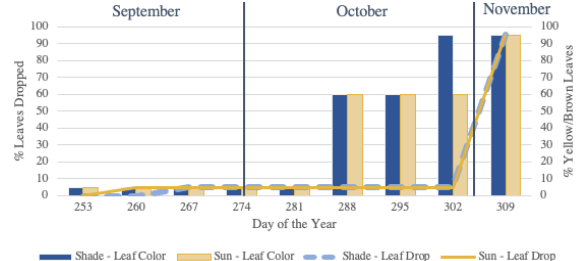
Figure 8. Temporal changes in leaf color change (bars) and leaf drop (lines) recorded in fall 2015 in the aspen trees growing in shaded (blue) and sunny (yellow) areas. October 2015 had fewer days with the minimum temperature dropping below the freezing point than other years. Despite the warmer temperature recorded in the first two months, the shaded tree changed its color one week before the sunny tree. However, both trees dropped their leaves at approximately same